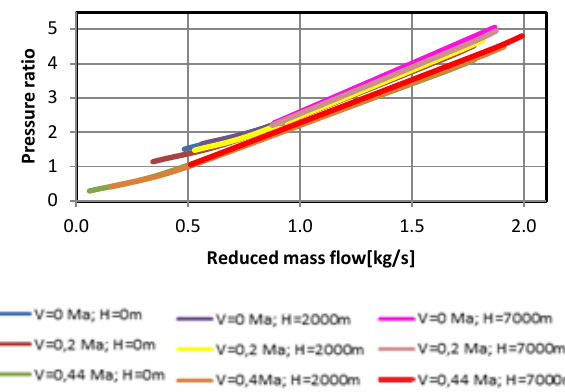
Fig. 4. Compressor map for centrifugal compressor of DGEN 380